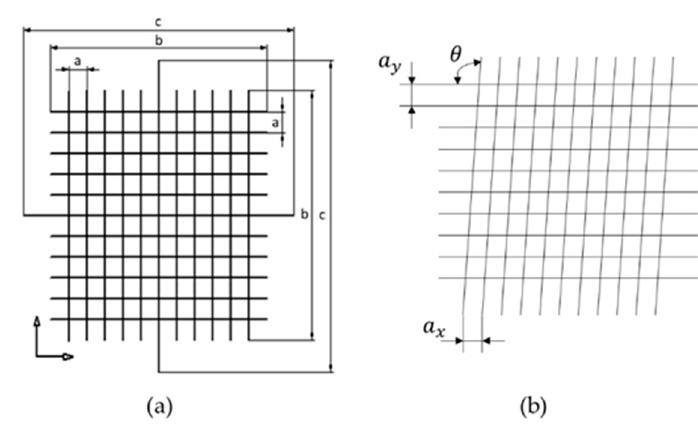
Figure 8. ( a ) The grid model and ( b ) it sources of error.